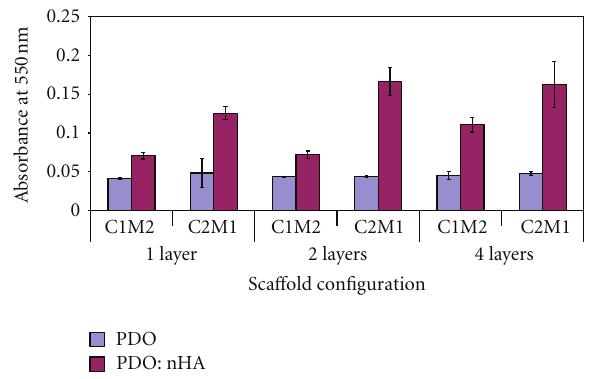
F 3: Alizarin red staining of multilayered scaffolds. Electro- spun PDO and PDO:nHA scaffolds were stacked on top of each other to get 2 or 4 layers. One group was compressed �rst (C1M2) and mineralized as multilayered scaffold while the other group was mineralized as individual sheets and compressed into a single unit (C2M1) aer SBF treatment. Following incubation, scaffolds were washed and stained for calcium using Alizarin red staining as described in Section